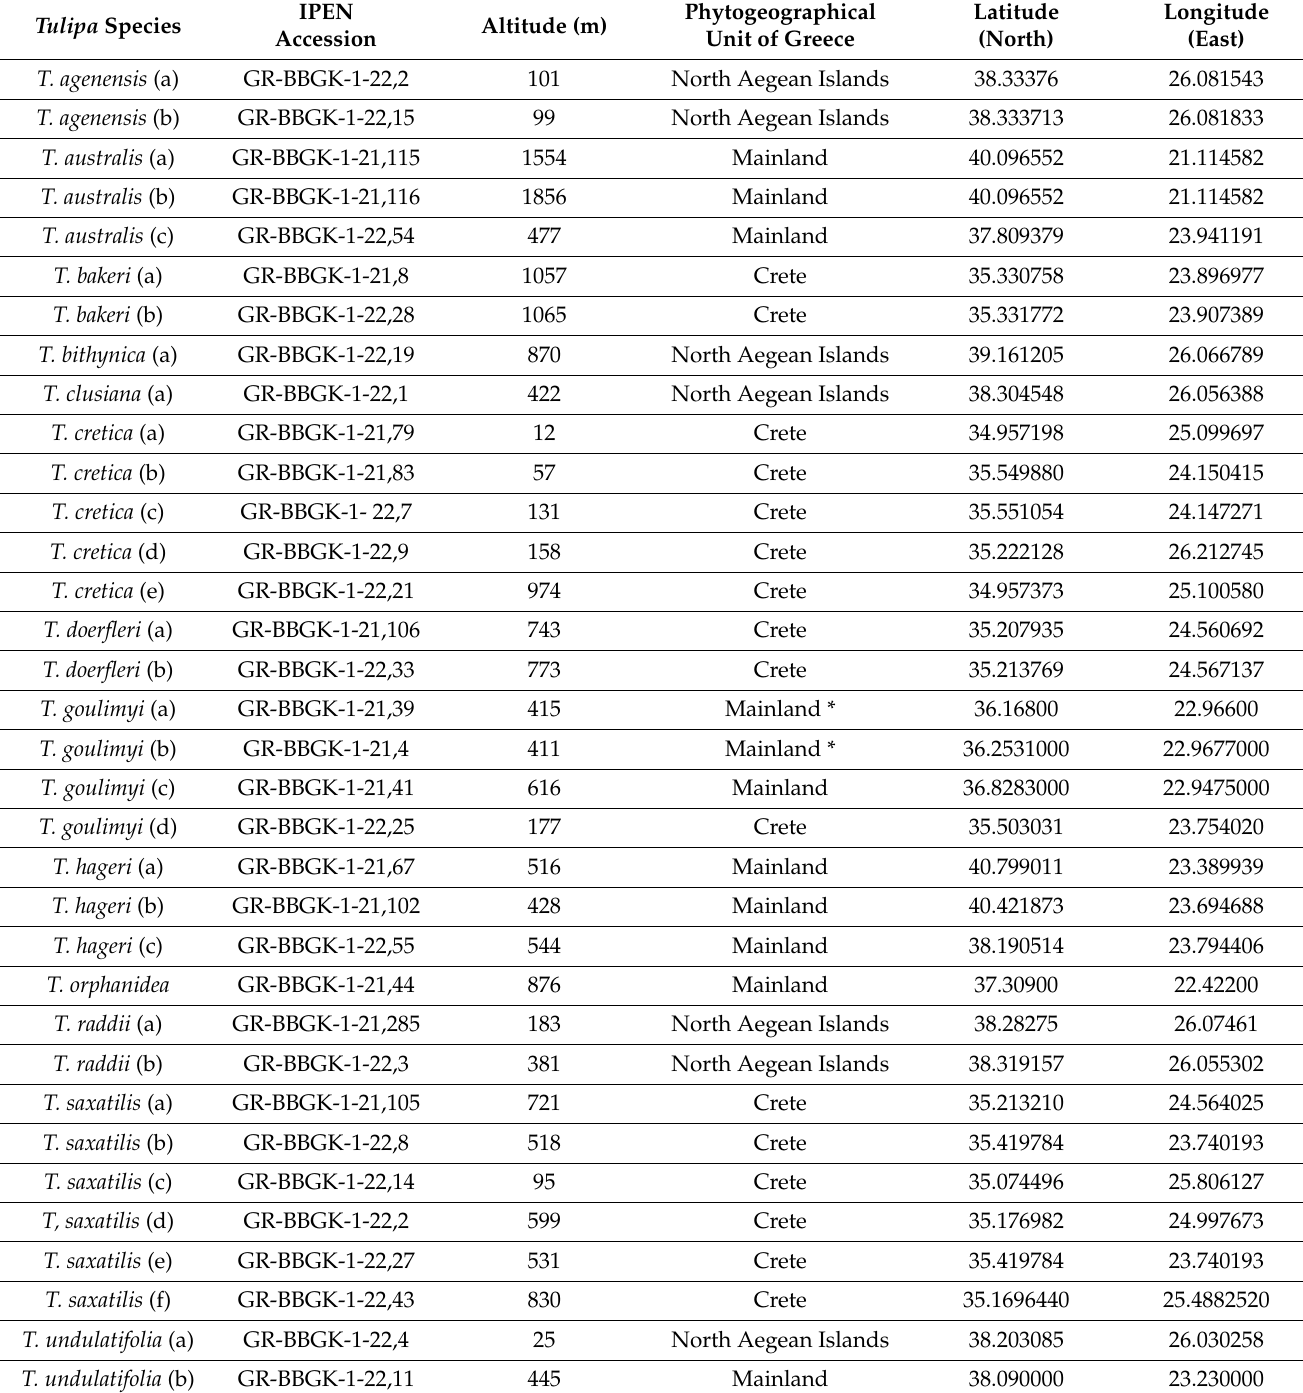
Table 1. Collection details and IPEN (International Plant Exchange Network) accession numbers associated with the living material samples regarding the Tulipa spp. from Greece studied herein. Different Tulipa spp. are arranged alphabetically. For each species, the letter in the parentheses denotes different tulip samples collected (1–6 samples per